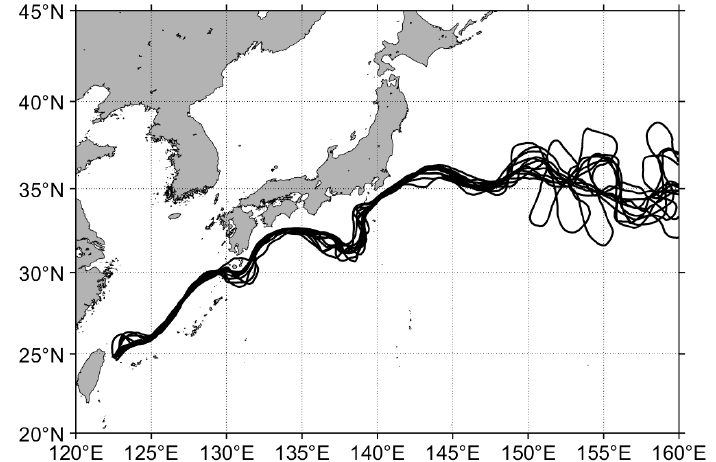
Figure 1. The monthly distribution of the main axis of Kuroshio extracted by multi-altimeters data in 2018.